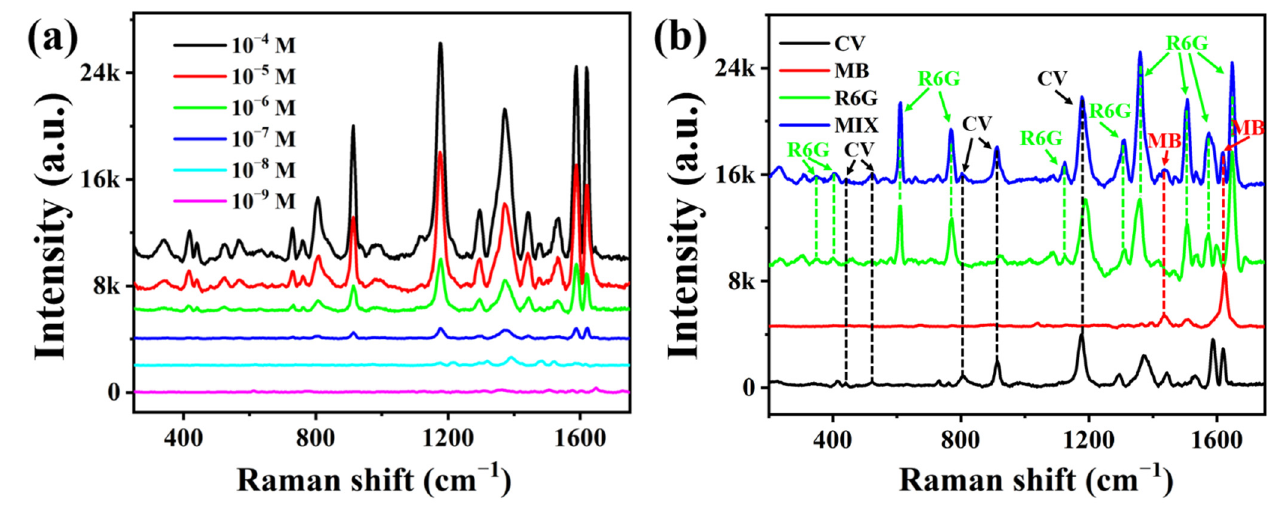
Figure 7. Quantitative and qualitative detection of dye molecules by Ag (315) @PDMS substrate. ( a ) SERS spectra of CV with different concentrations adsorbed on the Ag (315) @PDMS substrate. ( b ) SERS spectra of CV (black line), MB (red line), R6G (green line) and their mixtures (blue line).